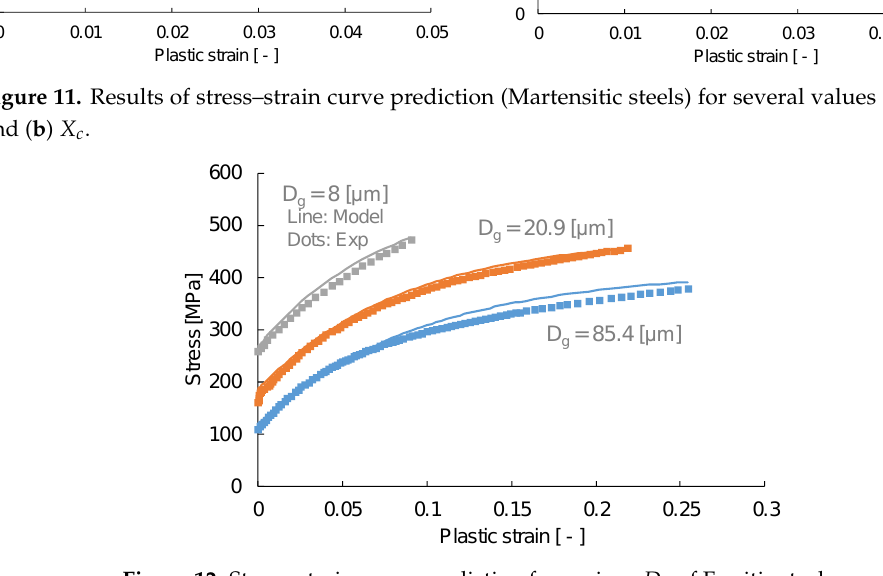
Figure 12. Stress–strain curve prediction for various D g of Ferritic